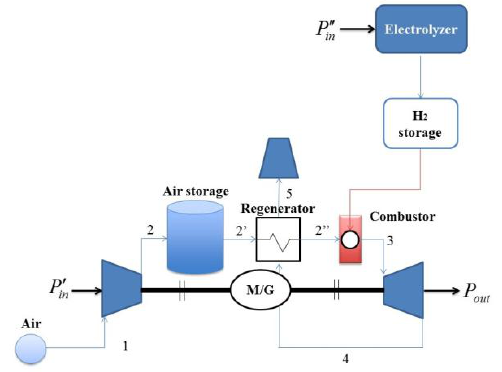
Figure 3. Regenerated hybrid storage system.